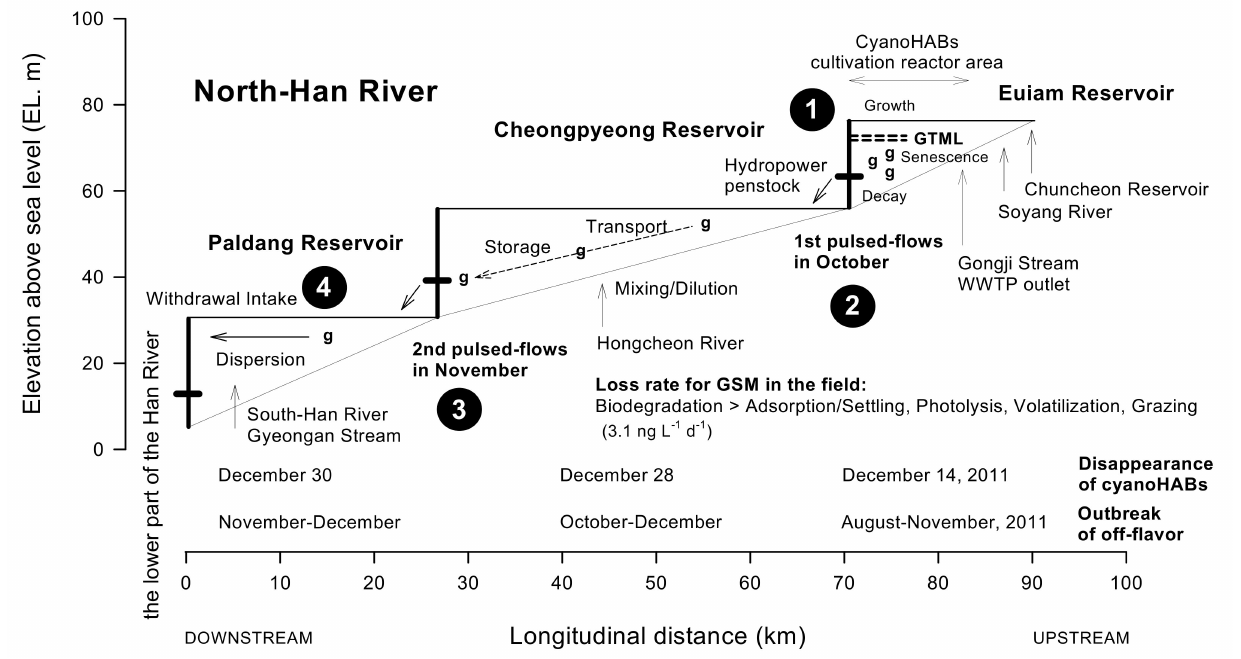
Longitudinal distance (km) Figure 10. A simplified conceptual diagram illustrating the fate and transport mechanisms of the cyanobacterial bloom (Korean synonym: green tide) and geosmin that occurred in a reservoir cascade (Euiam, Cheongpyeong, and Paldang Reservoirs) from late August to late December 2011. GTML, green tide (cyanoHAB) mat layer; g, geosmin (GSM); WWTP, wastewater treatment plant; cyanoHABs, bloom-forming harmful cyanobacteria. ❶ , occurrence and senescence of cyanoHABs by Dolichospermum circinale in the Euiam Reservoir; ❷ and ❸ , first and second hypolimnetic water release through the hydropower penstock of each reservoir, respectively; ❹ , outbreak of an off– flavor event in the Paldang Reservoir. The loss rate by biodegradation and other components was adopted from Graham et al. [7], Suffet et al. [19], and van Breemen et al. [25]. To determine the decrease and fate of the GSM released into the water body of a reservoir, the water is subjected to various phenomena, such as adsorption, sedimenta- tion, photolysis, volatilization, animal feeding, biodegradation, dispersion, and dilution [25,83]. The GSM between the Euiam and Paldang Reservoirs was most likely to be deliv- ered to the downstream reservoir after the rainy season and introduced into the hydro- power effluent, which was the only transport mechanism [43,84]. The Paldang Reservoir and lower part of the Han River were eventually affected, where water intake for drinking water treatment occurred (Figure 7; http://m.chosun.com (accessed on 9 December 2011)) [53]. If the continuous discharge (e.g., pulsed flow) from the upstream reservoirs (EAD and CPD) of the North Han River was maintained, the time for the GSM material to reach the downstream reservoir (PDD) could be reduced, and the adverse impacts on the water quality could be increased [40,78]. The GSM concentration was higher in the reservoirs (5–7100 ng L − 1 ) and shallow water than in the streams (4–24 ng L − 1 ), with a high frequency and extent of the Dolichospermum bloom (Appendix A). Generally, the GSM concentrations in the reservoirs decreased (60–70% of influent water) primarily because of adsorption, sedimentation, and biodegradation (3.1 ng L − 1 d − 1 ), as described in a previous study [25]. However, if internal productivity is high (e.g., dense bloom) because of aggravated an- thropogenic pollution factors, efforts to improve water quality may have adverse effects, which is intensified in eutrophic water bodies with shallow water depths [25]. In addition, GSM in stratified reservoirs with discharge systems in deep layers (middle or bottom) are mostly concentrated just below these layers, and effluents after destratification by turno- ver can hinder water use for several months [83].